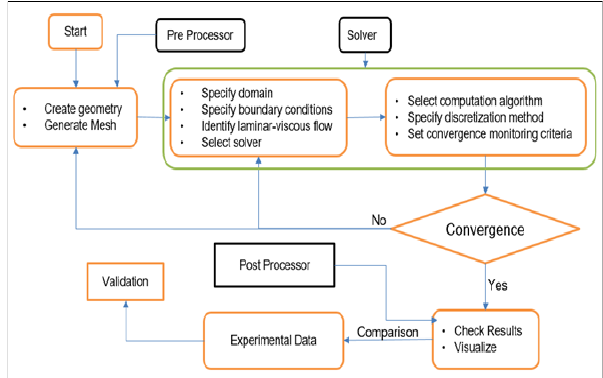
Figure 3. Methodology flow